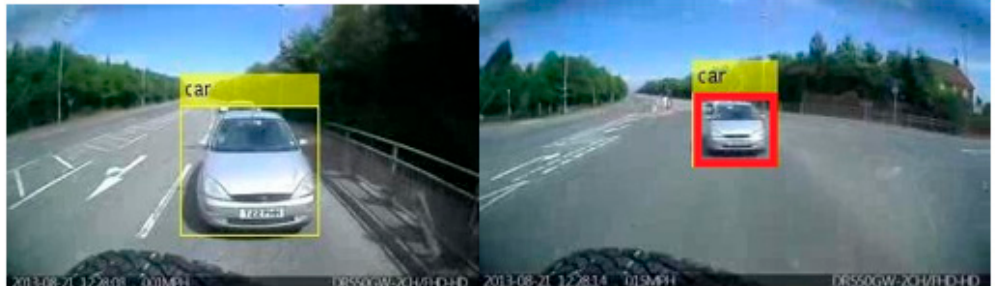
Figure 16. Tracked vehicle.